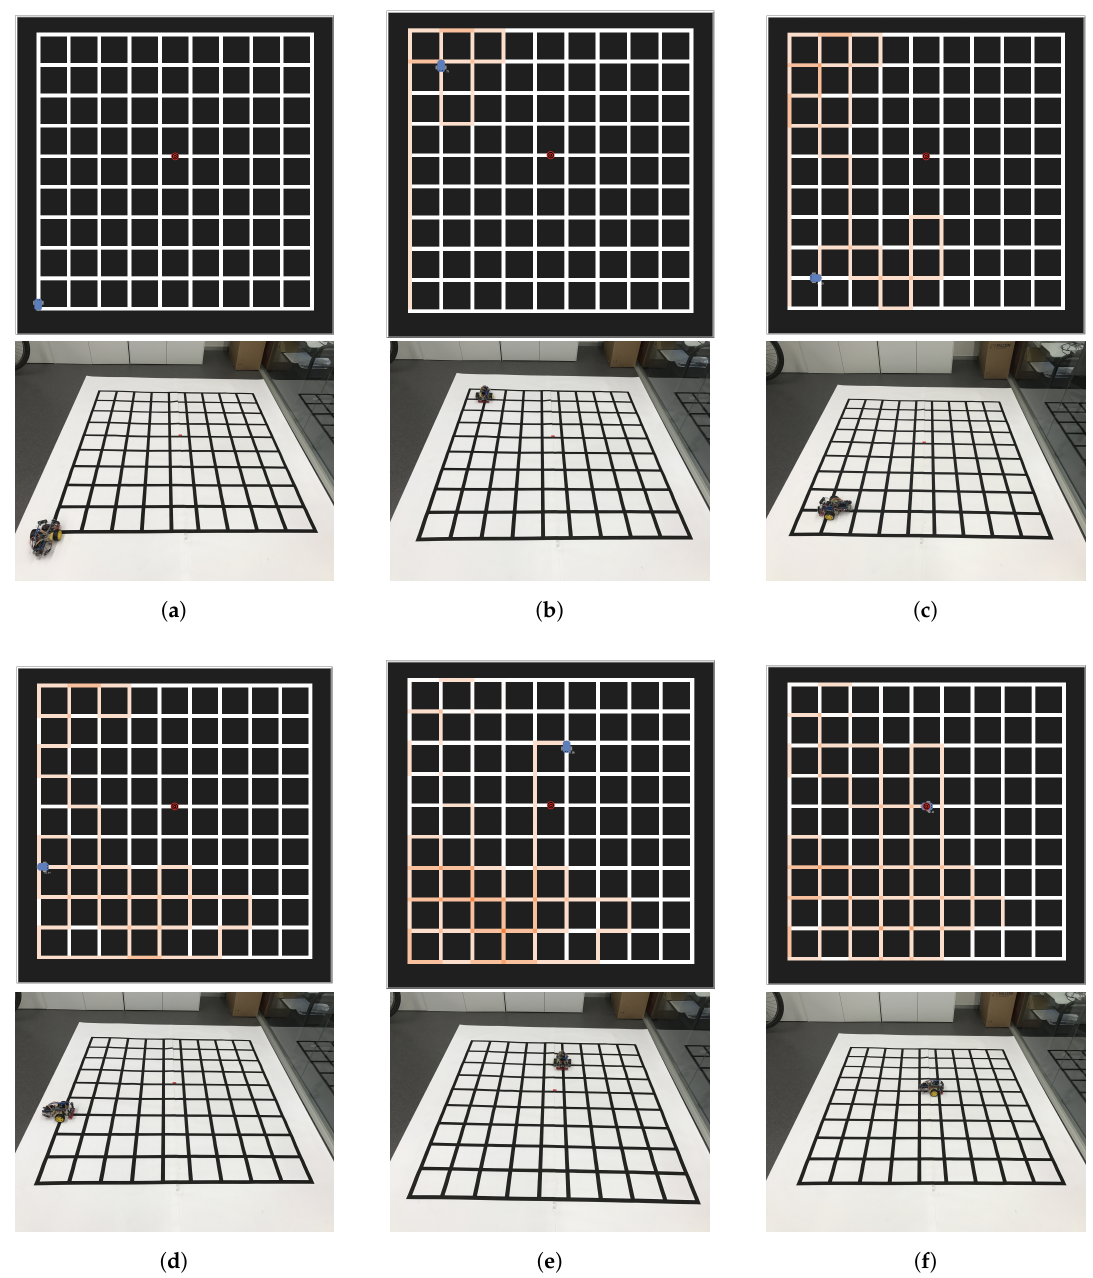
Figure 2. Robot experiment with Φ = 120. Snapshots captured every 200 steps. The orange traces correspond to the anti-pheromone level. ( a ) t = 0 (initial position); ( b ) t = 200; ( c ) t = 400; ( d ) t = 600; ( e ) t = 800; ( f ) t = 1019 (final position, the robot is on